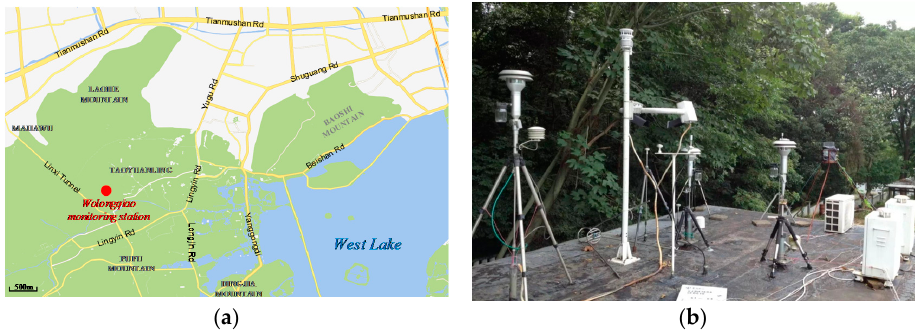
Figure 7. Wolongqiao monitoring station: ( a ) location; ( b ) appearance.